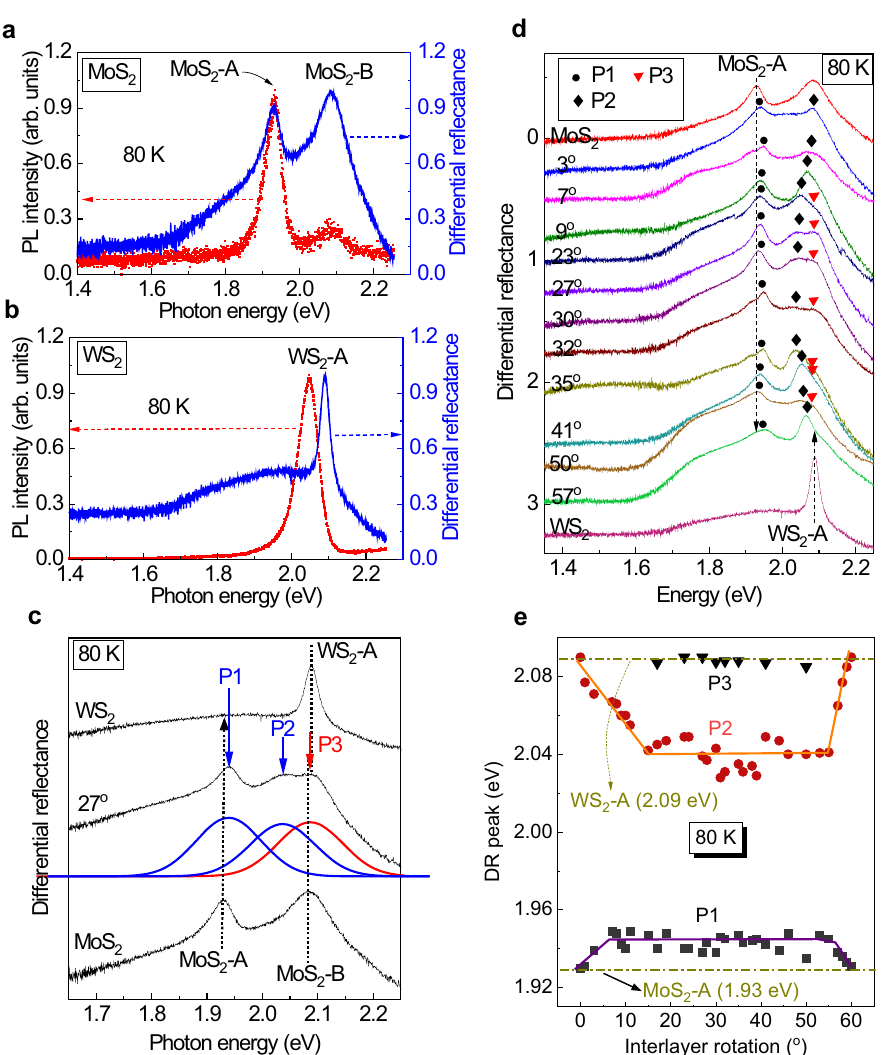
Fig. 3 Differential re fl ectance of twisted MoS 2 /WS 2 heterobilayers at 80 K. a , b DR and PL spectra of ( a ) typical MoS 2 and ( b ) WS 2 monolayers. c DR spectra of typical MoS 2 and WS 2 monolayers, and a typical MoS 2 /WS 2 bilayer at θ = 27°. The spectrum is resolved into fi tted curves, and the DR peaks of the MoS 2 and WS 2 intralayer excitons (MoS 2 -A/-B and WS 2 -A) are indicated. d Shifts of the DR spectra by successive variation of θ . Markers and dashed lines show the P1/P2/P3 and MoS 2 -A/WS 2 -A peaks, respectively. e P1, P2, and P3 peaks as functions of θ . Dashed lines show the locations of the MoS 2 -A and WS 2 - A